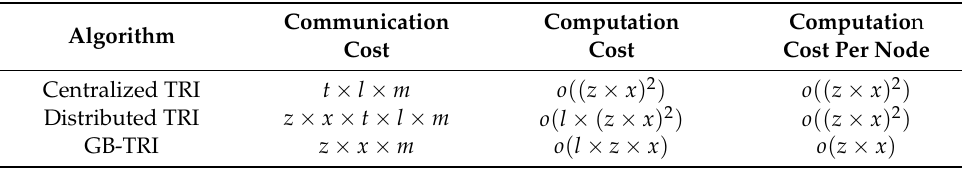
Table 2. Communication and computational cost analysis.